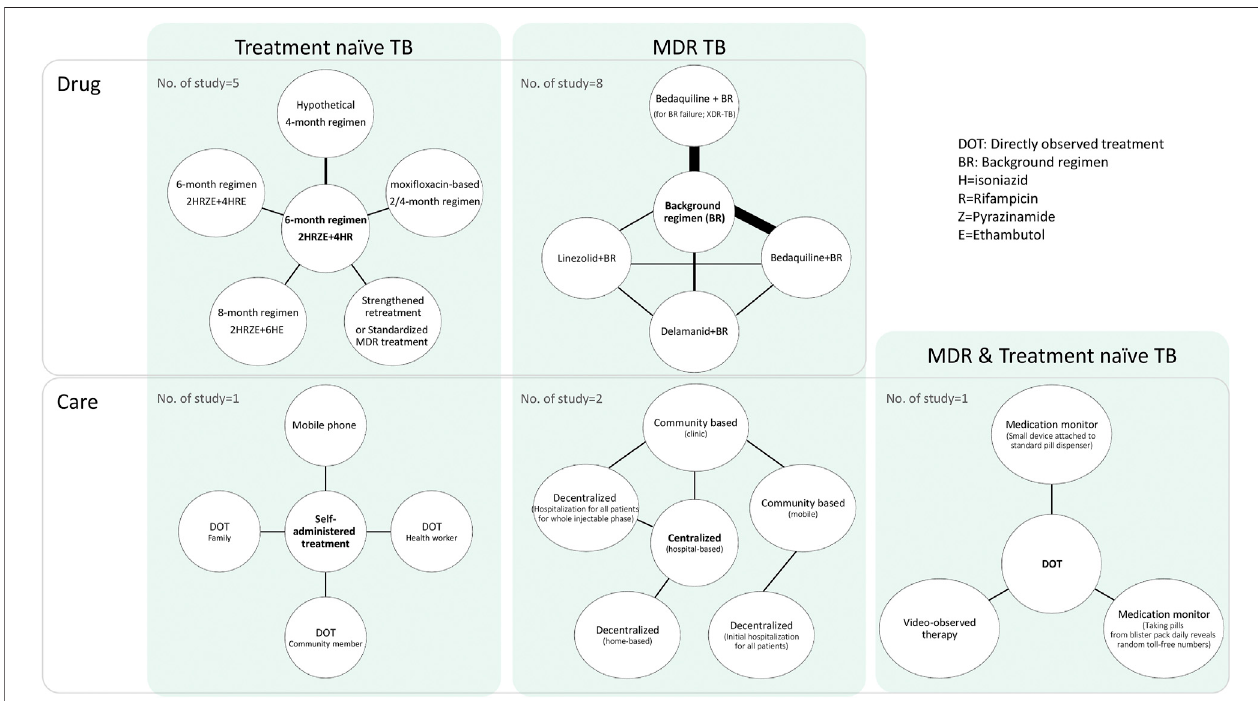
FIGURE 2 | Network diagram of the interventions and study